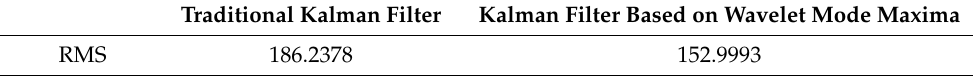
Figure 7. ( a ) Traditional Kalman filter fragment processing results; ( b ) Kalman filter fragment pro- cessing results based on wavelet mode maxima; ( c ) traditional Kalman filter processing distribution of experimental signal; ( d ) Kalman filter processing distribution based on wavelet mode maxima of experimental signal. experimental signal. Table 2. Comparison of RMS. Table 2. Comparison of